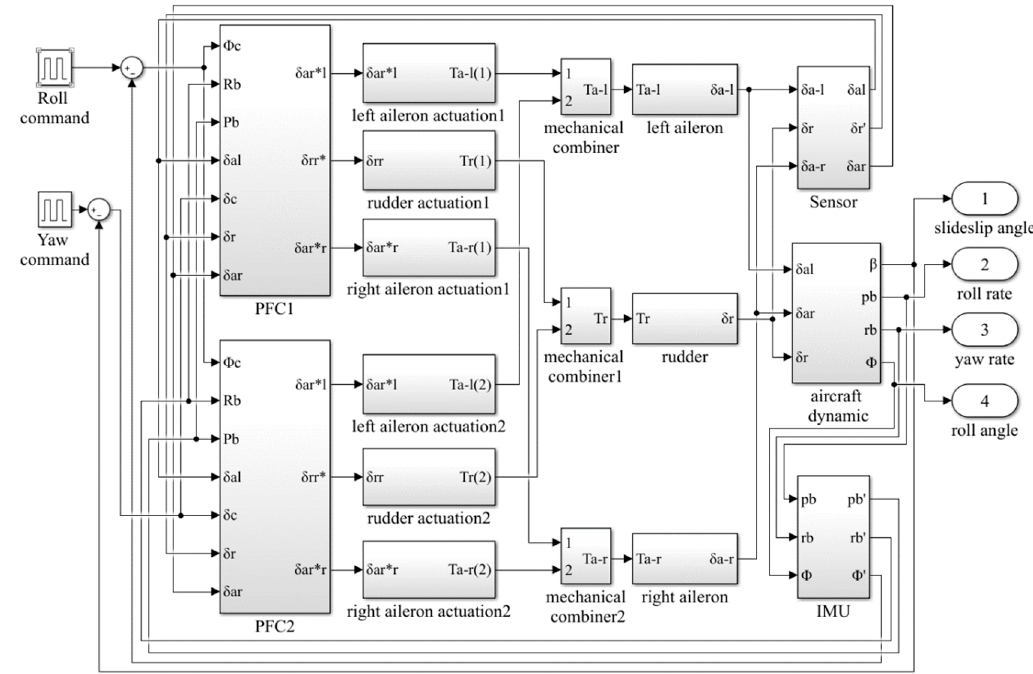
Figure 3. Nominal Simulink model of the lateral-directional flight control system.